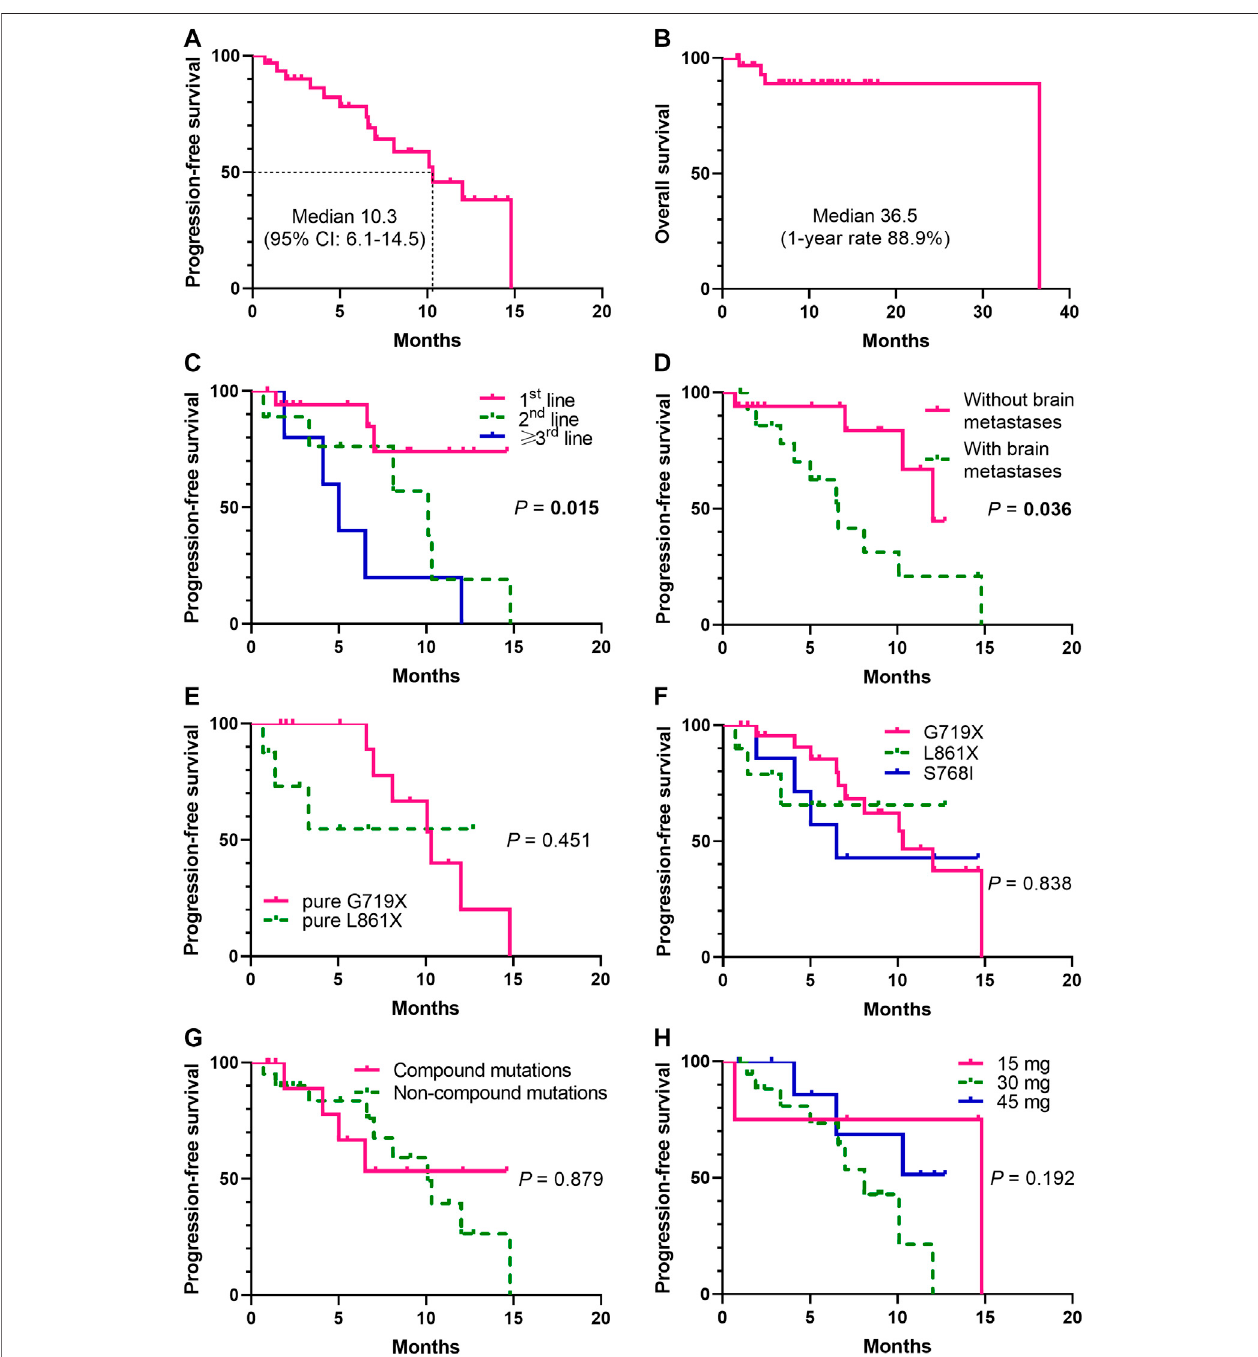
FIGURE 3 | Kaplan-Meier analysis of progression-free survival (PFS) and overall survival (OS) ( N = 32). The Kaplan-Meier curves were shown for PFS ( Figure 3A ) and OS ( Figure 3B ). Signi fi cant difference was observed ( p = 0.015) in the median PFS (mPFS) of patients treated with dacomitinib in different lines ( Figure 3C ). Signi fi cant unfavorable effect of brain metastases on PFS ( p = 0.036) ( Figure 3D ) was shown. Patients harboring different mutation subtypes demonstrated different mPFS ( Figures 3E,F ), though no signi fi cant difference was observed. No signi fi cant difference between compound mutations and non-compound mutations groups was found ( p = 0.879) ( Figure 3G ). Patients received different dacomitinib doses showed no different mPFS ( p = 0.192) ( Figure 3H ).